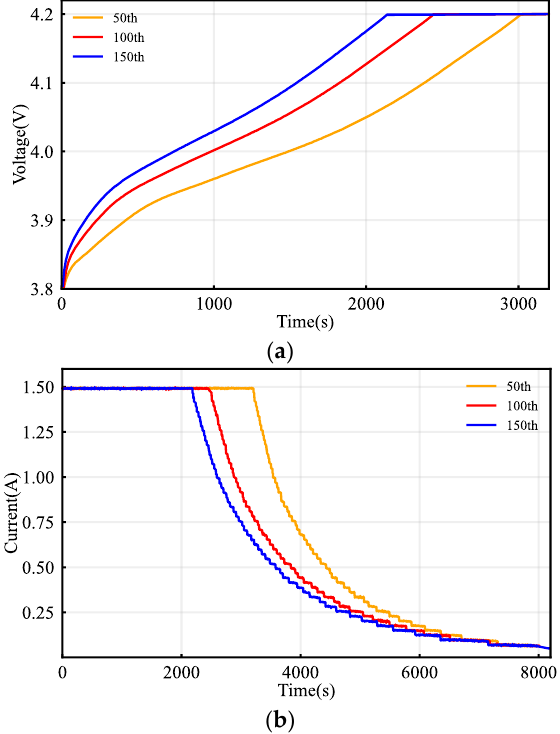
Figure 3. ( a ) Charge voltage curves from 3.8 V to 4.2 V during different cycles; ( b ) current curves during the whole charging process during different cycles.